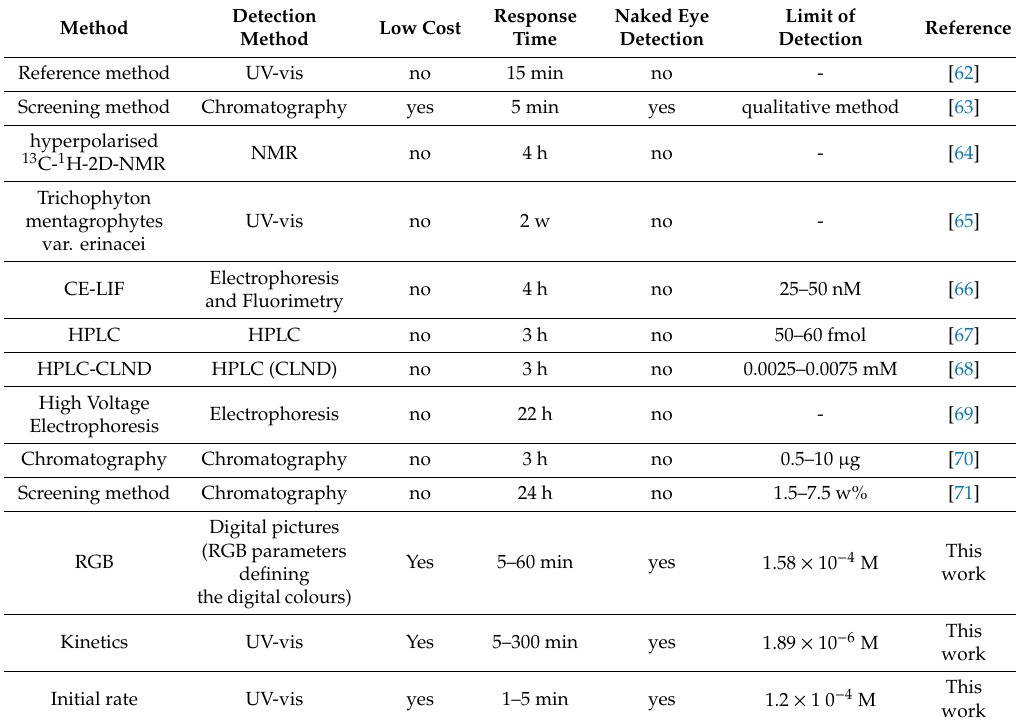
Table 3. Comparative table of di ff erent amino acid analytical